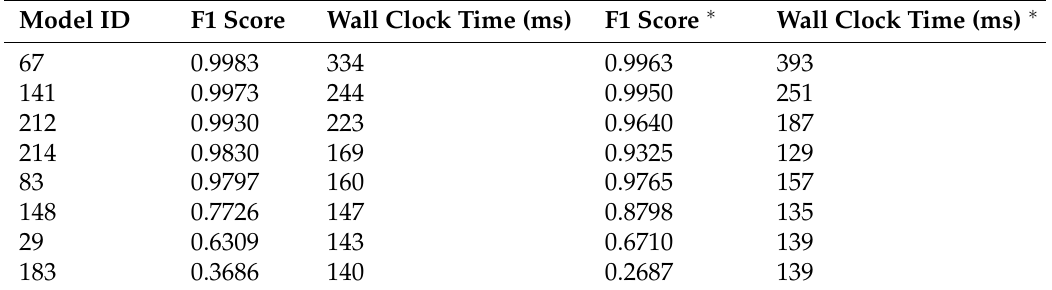
Table 3. Models on the wall clock Pareto front (columns with ∗ report results for new test